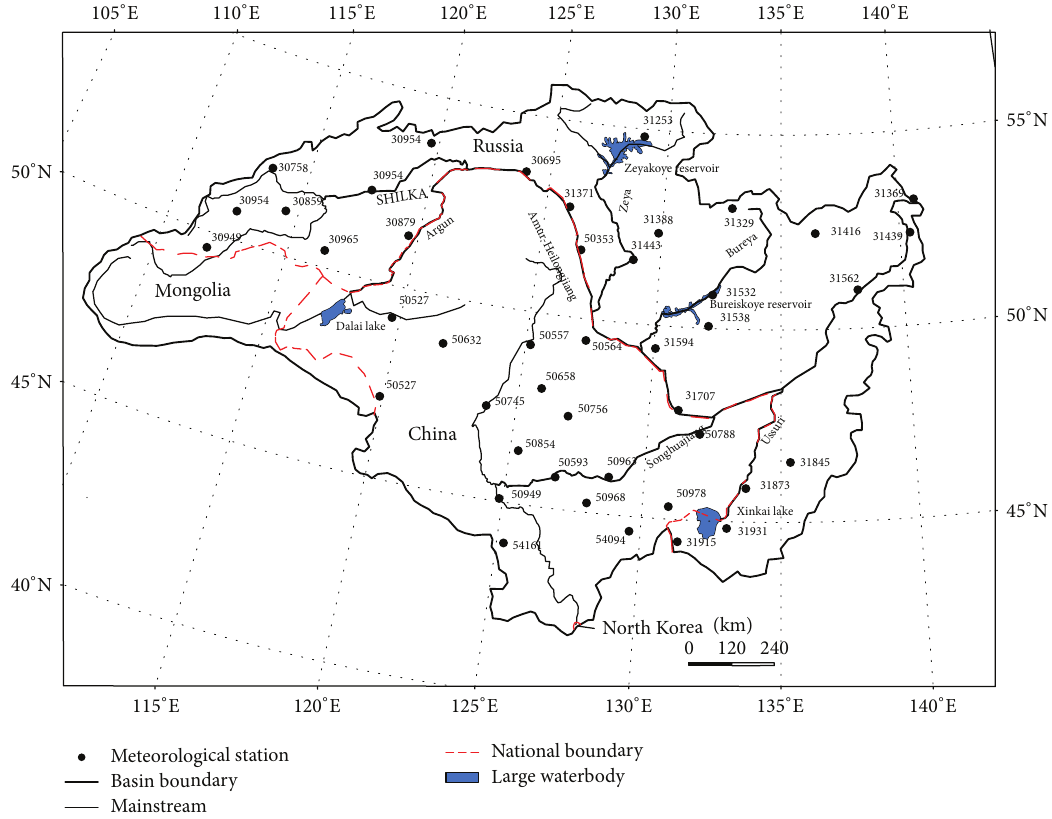
Figure 1: Locations of the 44 meteorological stations in the Amur River